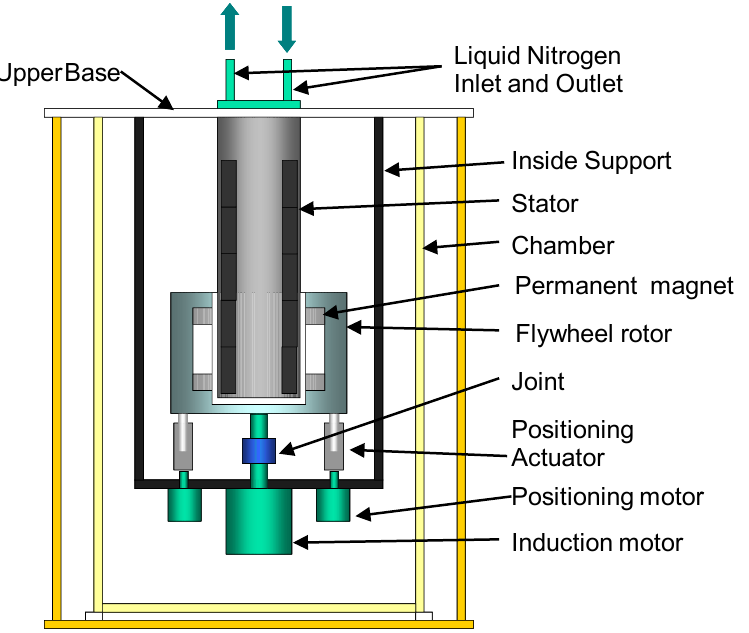
Figure 1. Schematic illustration of flywheel energy storage system.